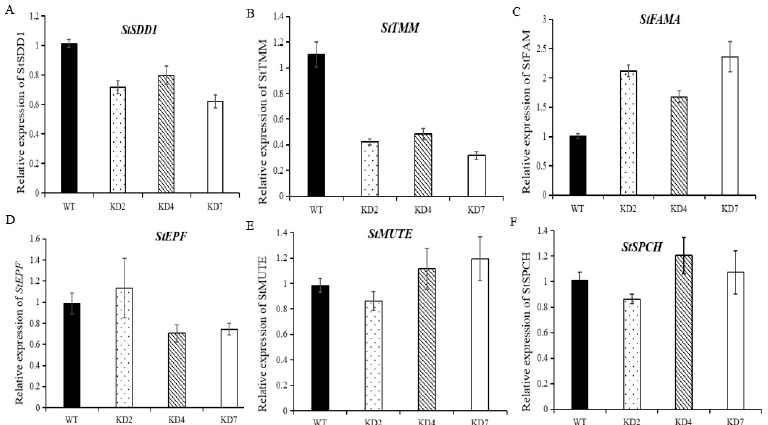
Figure 9. Expression of stomatal development-related genes in transgenic and WT plants. ( A – F ) Expression of the stomatal development genes StSDD1 ( A ), StTMM ( B ), StFAMA ( C ), StEPF ( D ), StMUTE ( E ), and StSPCH ( F ).